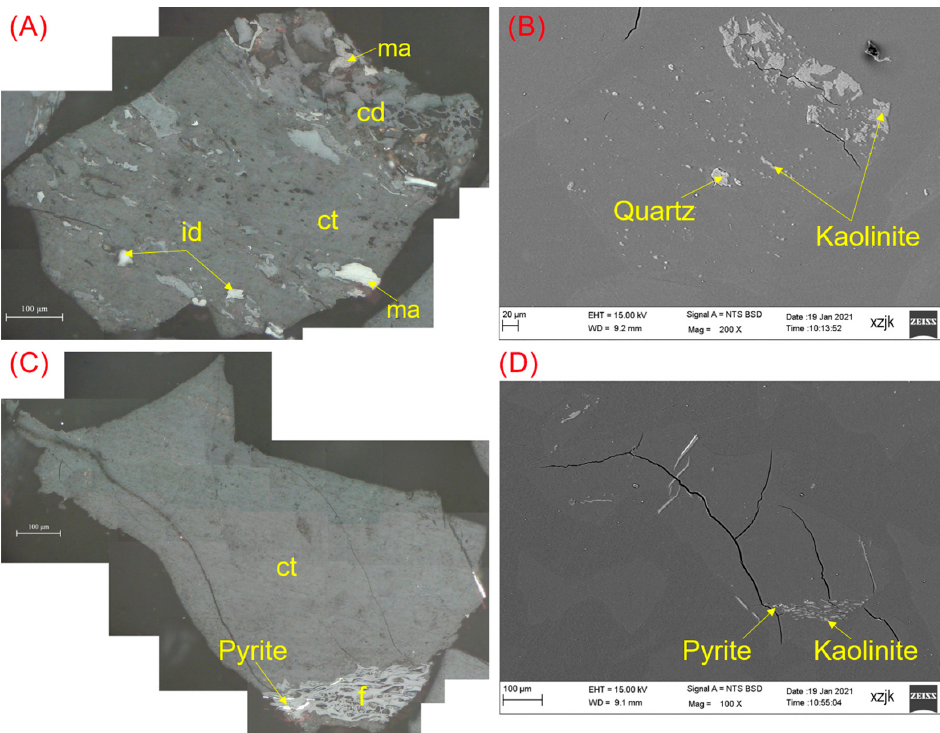
Figure 5. Microscope and SEM–EDS identification of DLTV: ( A ) A particle composed of large-area collotelinite (ct) and some collodetrinite (cd) with specked inertodetrinite (id) and macrinite (ma); ( B ) SEM–EDS image of ( A ); ( C ) A collotelinite (ct) particle intruded by a small piece of fusinite (f) with cell-filling pyrite; ( D ) SEM–EDS image of ( C ).